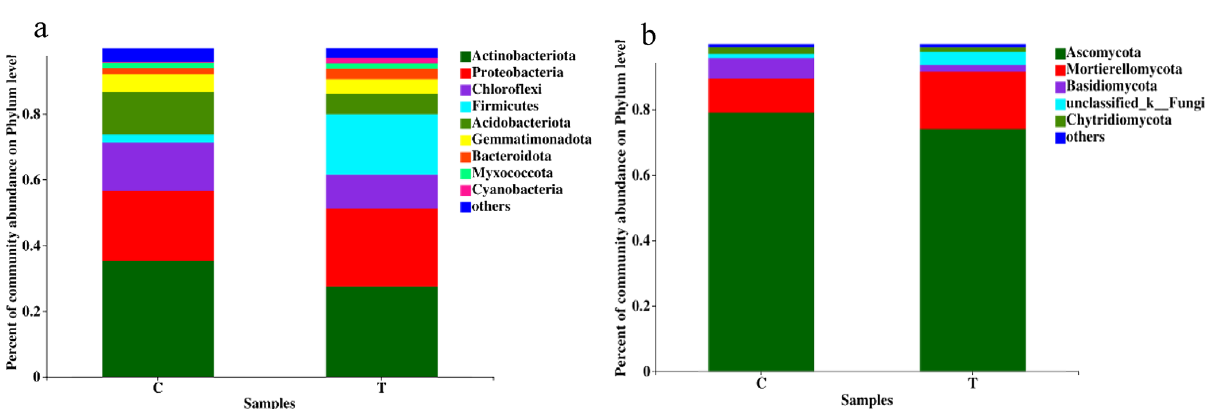
Figure 3. Bacterial ( a ) and fungal ( b ) community composition on Phylum level at different